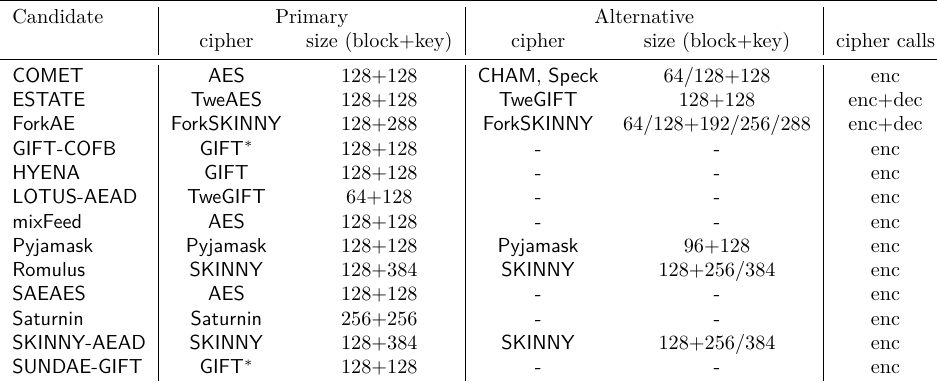
Table 1: The list of second-round NIST LWC candidates that are based on block ciphers. GIFT refers to the original block cipher from [BPP + 17], and GIFT ∗ refers to the version that assumes different ordering of the input bits and the key [BCI + 19, BBP +